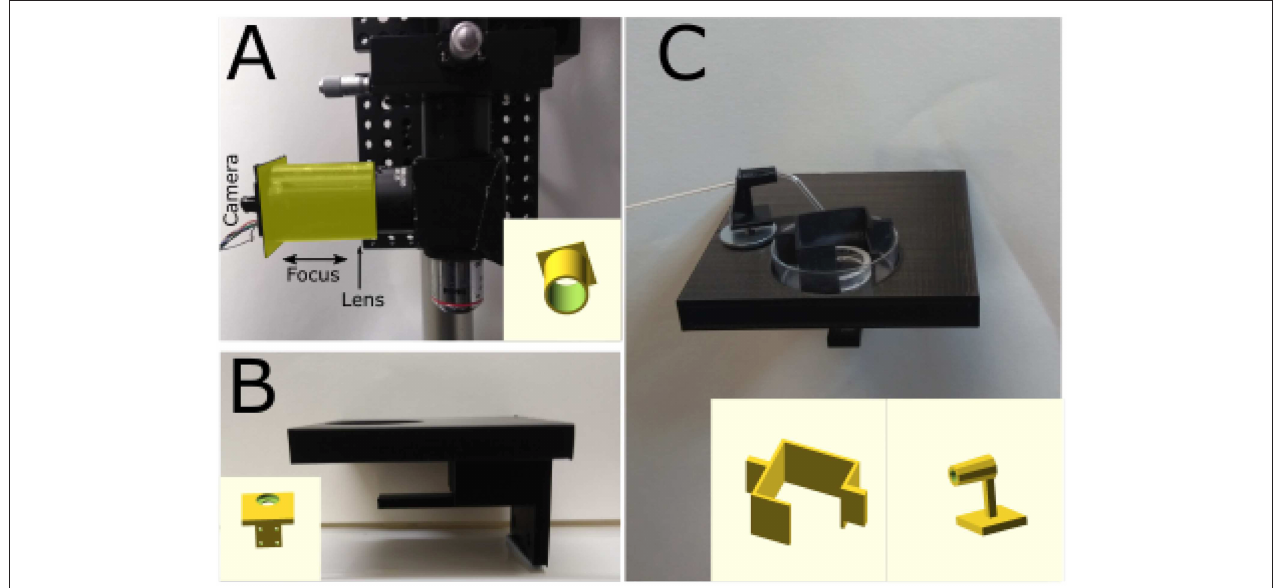
FIGURE 2 | 3D-printed components. (A) Photograph of a simple adaptor (highlighted in the yellow) for mounting a webcam board onto a Thorlabs 1" lens tube. The lens focusing the image on the sensor is placed inside the tube and the 3D-printed adaptor can be moved to focus the image. Insert: 3D model of the adaptor. (B) Photograph of stage mounted on 3-axis translator. Metal disks were glued and covered with transparent plastic to avoid DAB-induced oxidation. Insert: 3D model of the stage. (C) Sample in a 35 mm petri dish held in position by a 19 mm glass ring with nylon string across its middle and plastic box that prevents sample movement and bubbles covering the sample.The sample would placed under the glass ring. Glass capillary holder with a magnet mounted at its bottom to hold it in position. The capillary is used to oxygenate the solution and facilitate DAB photoconversion. Insert: 3D model of petri dish box and capillary